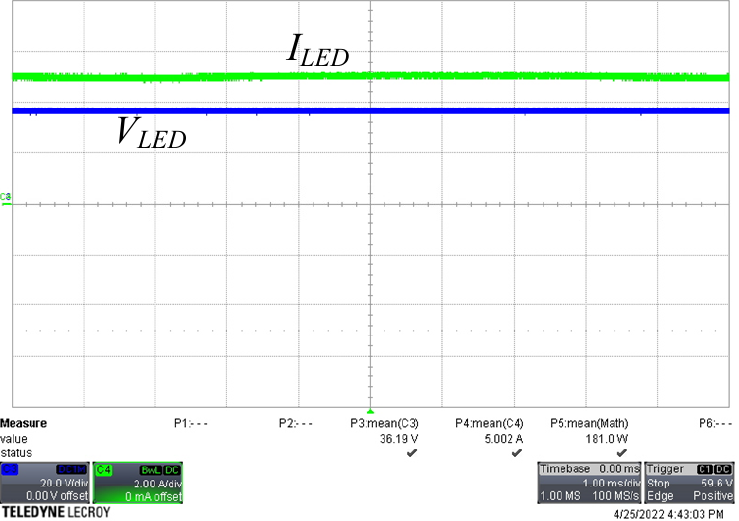
Figure 11. Waveforms of LED voltage and current ( V LED : 20 V/div, I LED : 2 A/div, time: 1 ms/div). The LED power was controlled by adjusting the switching frequency. The mea- sured efficiency curves over a load range of 25% to 100% rated power are shown in Figure 12. Efficiency slightly dropped when the LEDs were dimmed from 80% to 25% of the rated